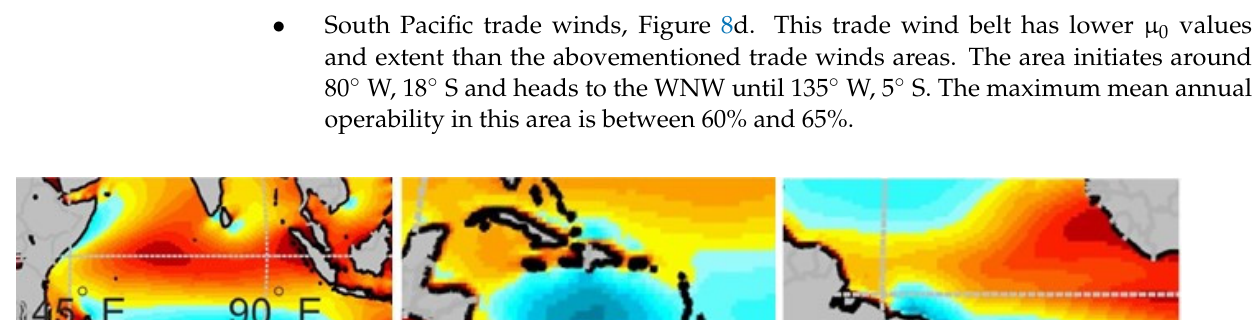
10 of 28 Figure 6. Global distribution of the annual mean operability. 4.1.1. Annual Mean Operability in the Trade Winds Belts Trade winds are generated by the atmospheric subsidence created by the subtropical high pressures. At surface level, trade winds blow from NE to E in the NH and from SE to E in the SH. Among the trade winds belts, the following areas have µ 0 over 75%: The Indian Ocean trade winds, in a strip of about 22 degrees longitude and 4 degrees latitude, centered in 86° E 15° S, see zoom of Figure 7a. •